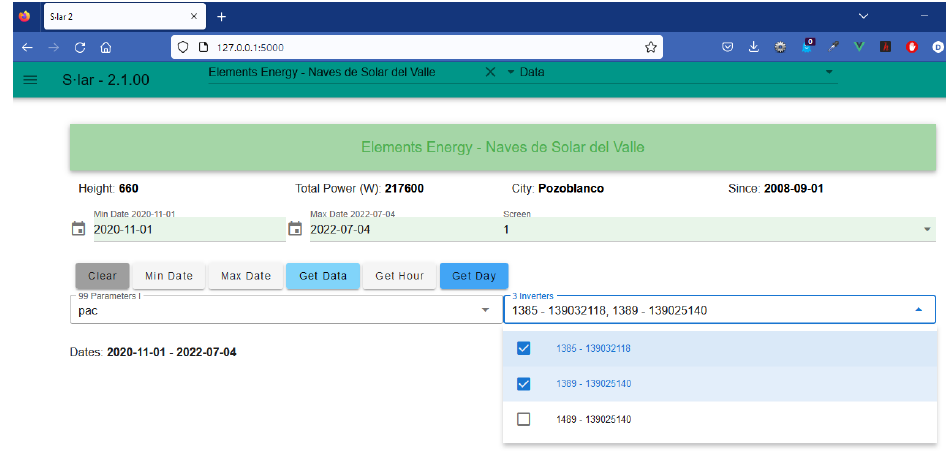
Figure 7. Image of the S · lar 2 application screen, in which the selection of two inverters of the selected PV plant (named Element Energy) is performed.